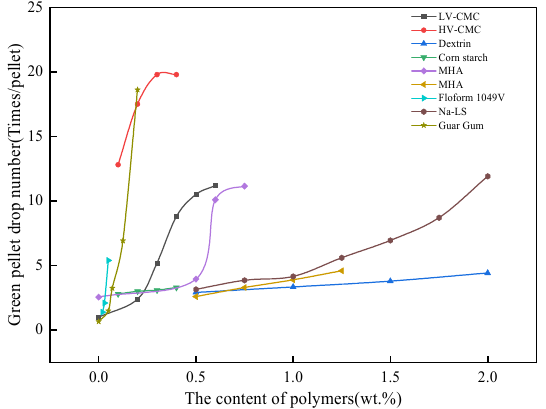
Figure 4. The effect of organic polymers on the green pellet drop strength [51–59].